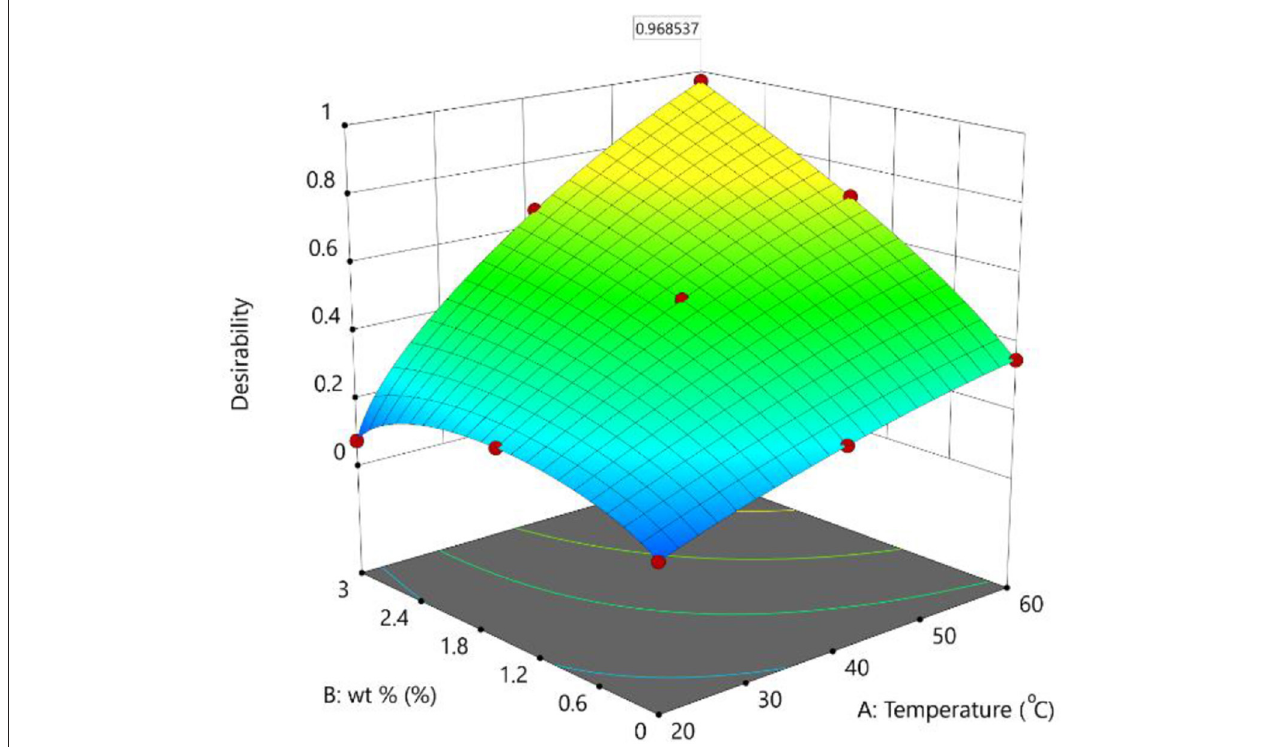
FIGURE 7 | 3D surface plot of temperature, wt.%, and